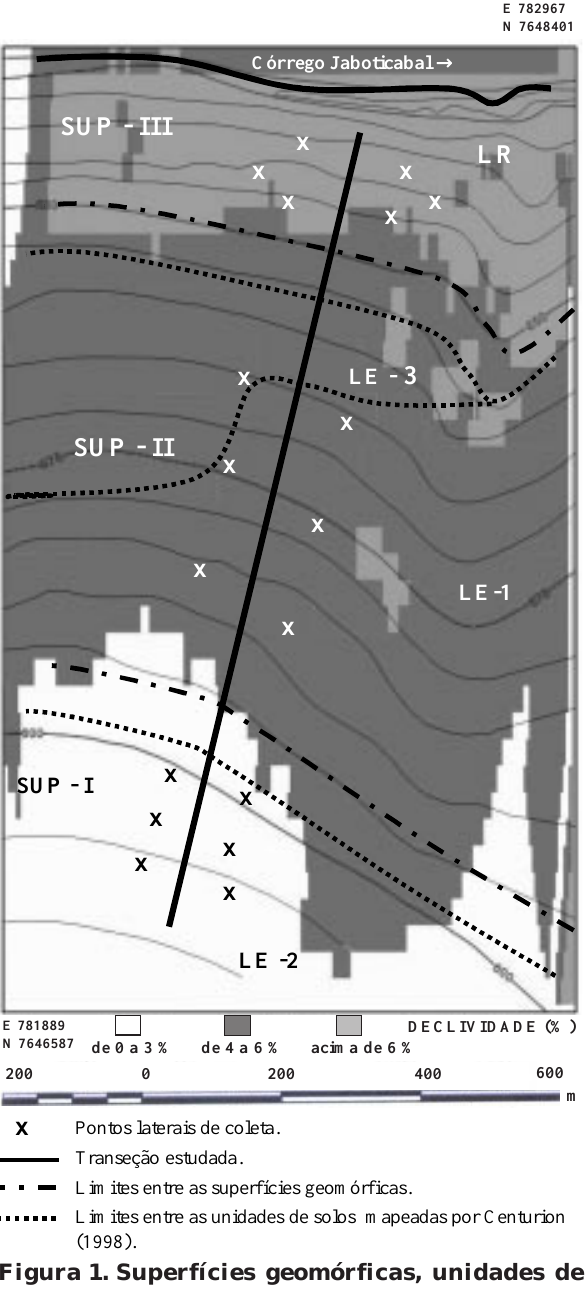
Figura 1. Superfícies geomórficas, unidades de solos antes mapeadas (Centurion, 1998) e classes de declividade obtidas a partir de “modelo de elevação digital de